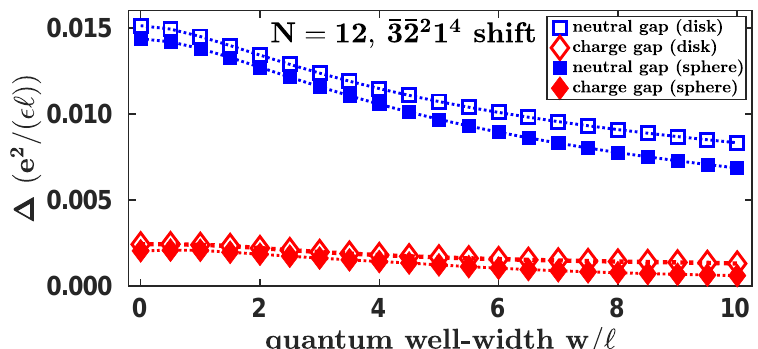
Figure 4: (color online) The second Landau level charge (red diamonds) and neutral (blue squares) gaps for N = 12 electrons at the shift corresponding to the ¯3¯2 2 1 4 state at ν = 3 / 8 evaluated in the spherical geometry using the spherical (filled symbols) and disk pseudopotentials (open symbols) for various well-widths w